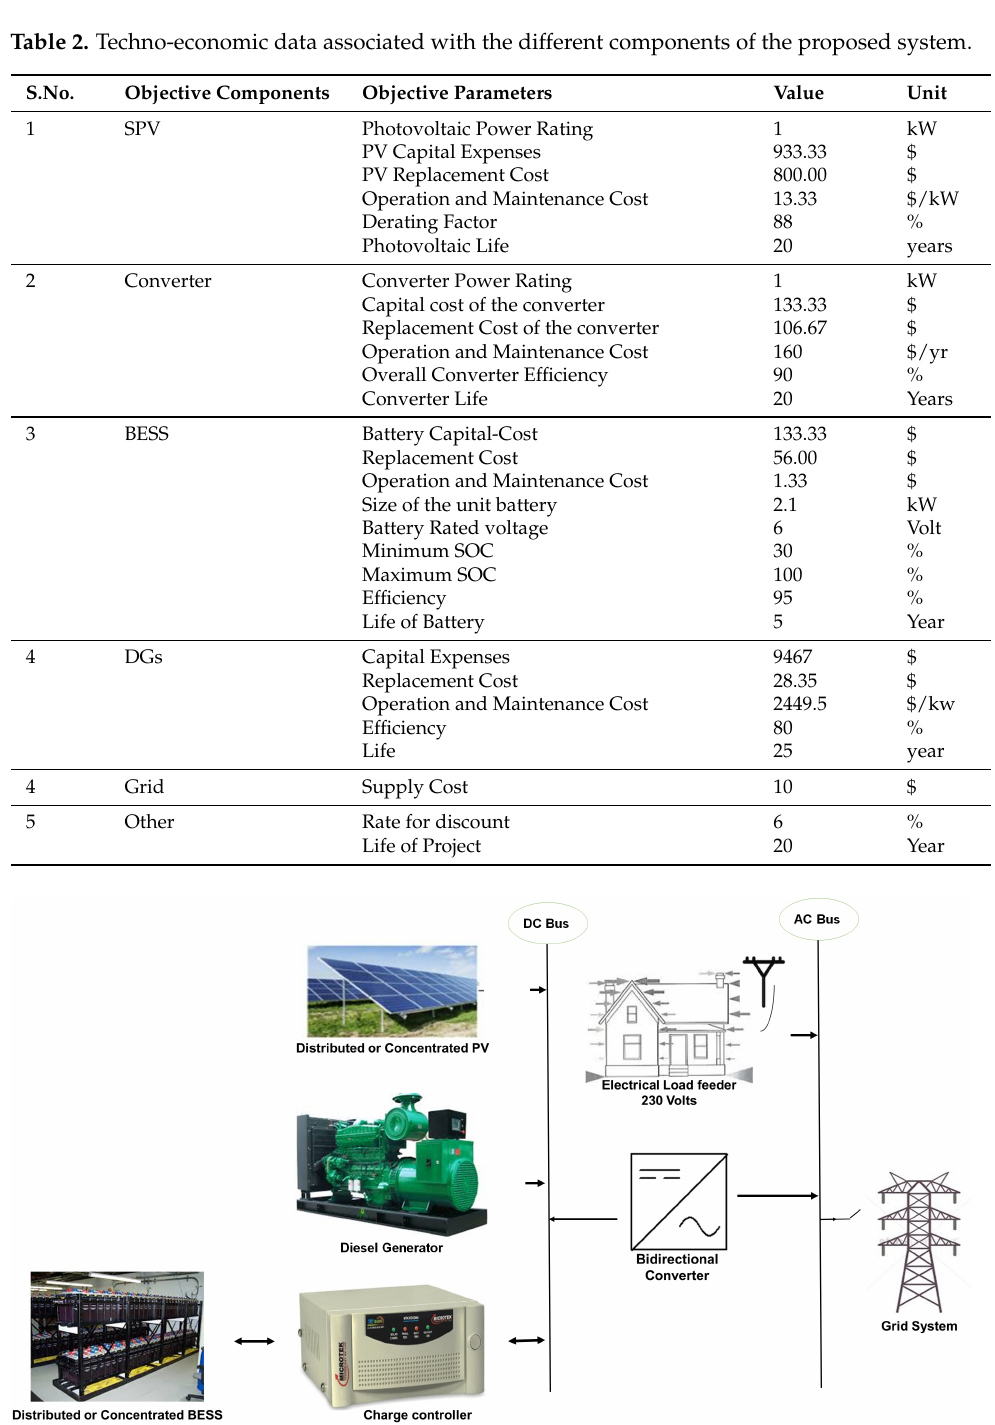
Figure 2. An illustration of proposed microgrid